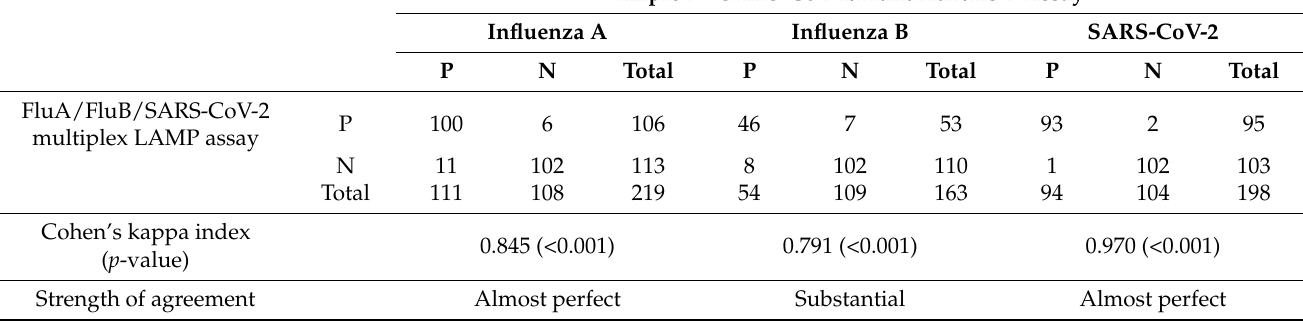
Table 6. Kappa values for calculating agreement between the FluA/FluB/SARS-CoV-2 multiplex LAMP assay and Allplex™ SARS-CoV-2/FluA/FluB/RSV assay. Allplex™ SARS-CoV-2/FluA/FluB/RSV Assay